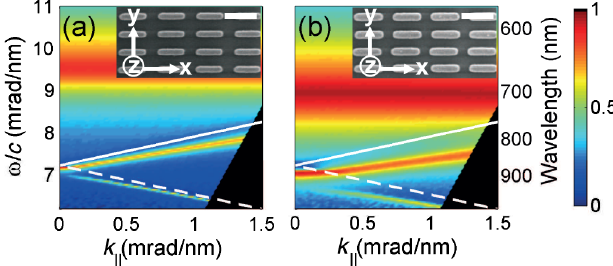
FIG. 1. Extinction spectra as a function of k k for an array of gold nanorods of dimensions (a) 420 (cid:1) 85 (cid:1) 40 nm 3 and (b) 450 (cid:1) 120 (cid:1) 38 nm 3 . The insets of (a) and (b) display scanning electron micrographs of the corresponding arrays; the scale bars denote 500 nm. The incident light is polarized along the y direction, probing the short axis of the nanorods. The lattice ¼ 600 nm and a ¼ 300 nm for both arrays. constants are a x y The solid and dashed white lines representing the ðþ 1 ; 0 Þ and ð(cid:3) 1 ; 0 Þ Rayleigh anomalies, respectively, are equal in both cases. The dispersionless resonances on the high-frequency side of the spectra are the dipolar localized surface-plasmon resonances for the short axis of the nanorods, whereas the narrower and dispersive resonances below the Rayleigh anoma- lies are the surface lattice